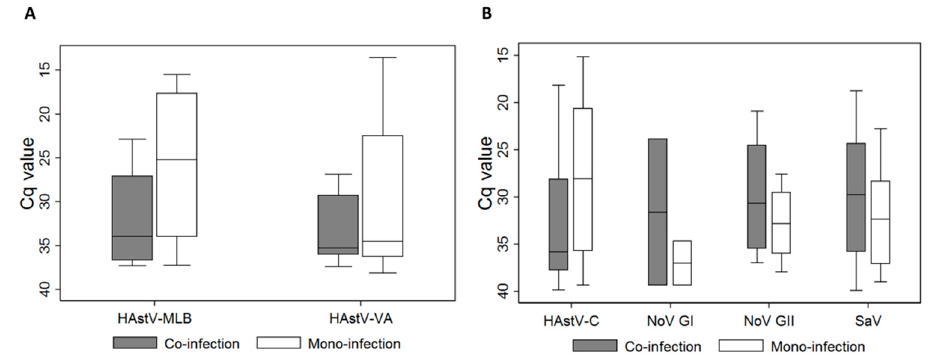
Figure 3. Median Cq values and confidence intervals for novel astroviruses ( A ) and other enteric viruses ( B ) according to mono- or co-infection status. Rotavirus and adenovirus were excluded from the analysis, as samples positive for these viruses by immunochromatography were excluded from the study. There was a statistical di ff erence when comparing the Cq value during co-infection and mono-infection for classical HAstVs ( p = 0.042 by Pearson chi2 test with continuity correction). HAstV-MLB: MLB human astrovirus; HAstV-VA: VA human astrovirus HAstV-C: classic human astrovirus; NoV: norovirus: GI: genogroup I; GII: genogroup II; SaV: sapovirus.